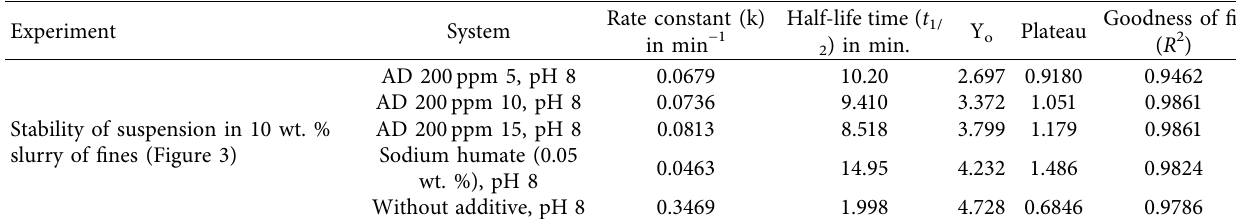
Rate constant (k) Goodness of fit Half-life time ( t 1/ Y o Plateau in min − 1 ( R 2 ) 2 ) in min.